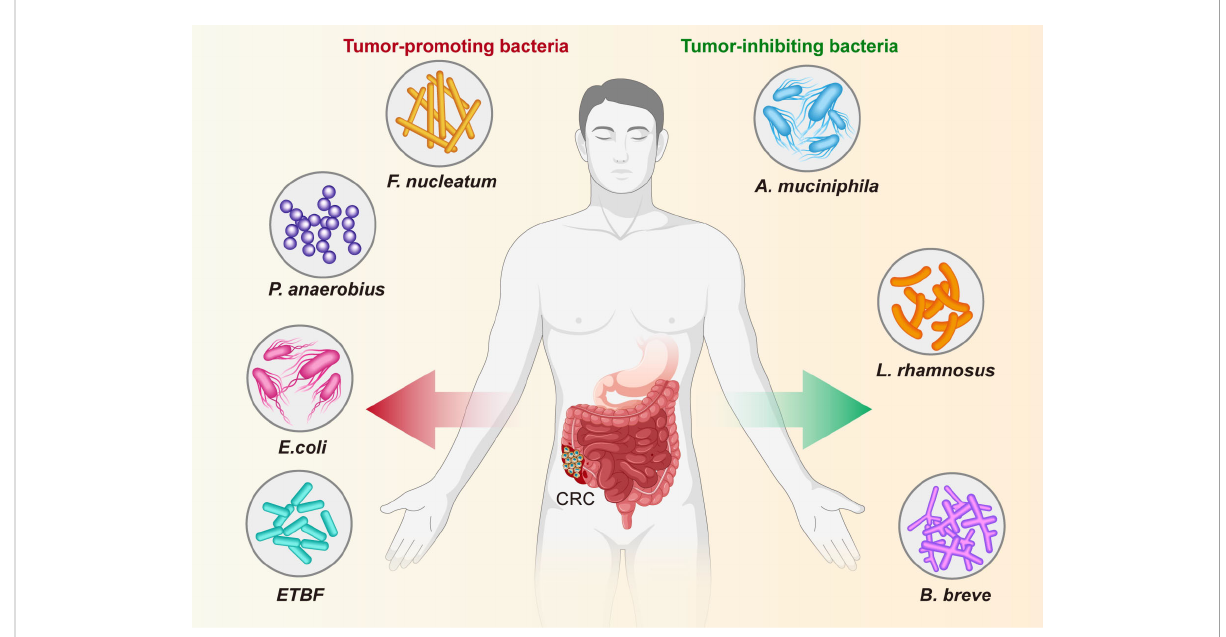
FIGURE 8 Speci fi c bacteria linked to CRC. The bacteria species including F nucleatum , E coli , P. anaerobius and ETBF have been identi fi ed as the pathogenic bacteria to drive CRC, while other bacteria, including (A) muciniphila , L. rhamnosus , and (B) breve are known to have an inhibitory effect on